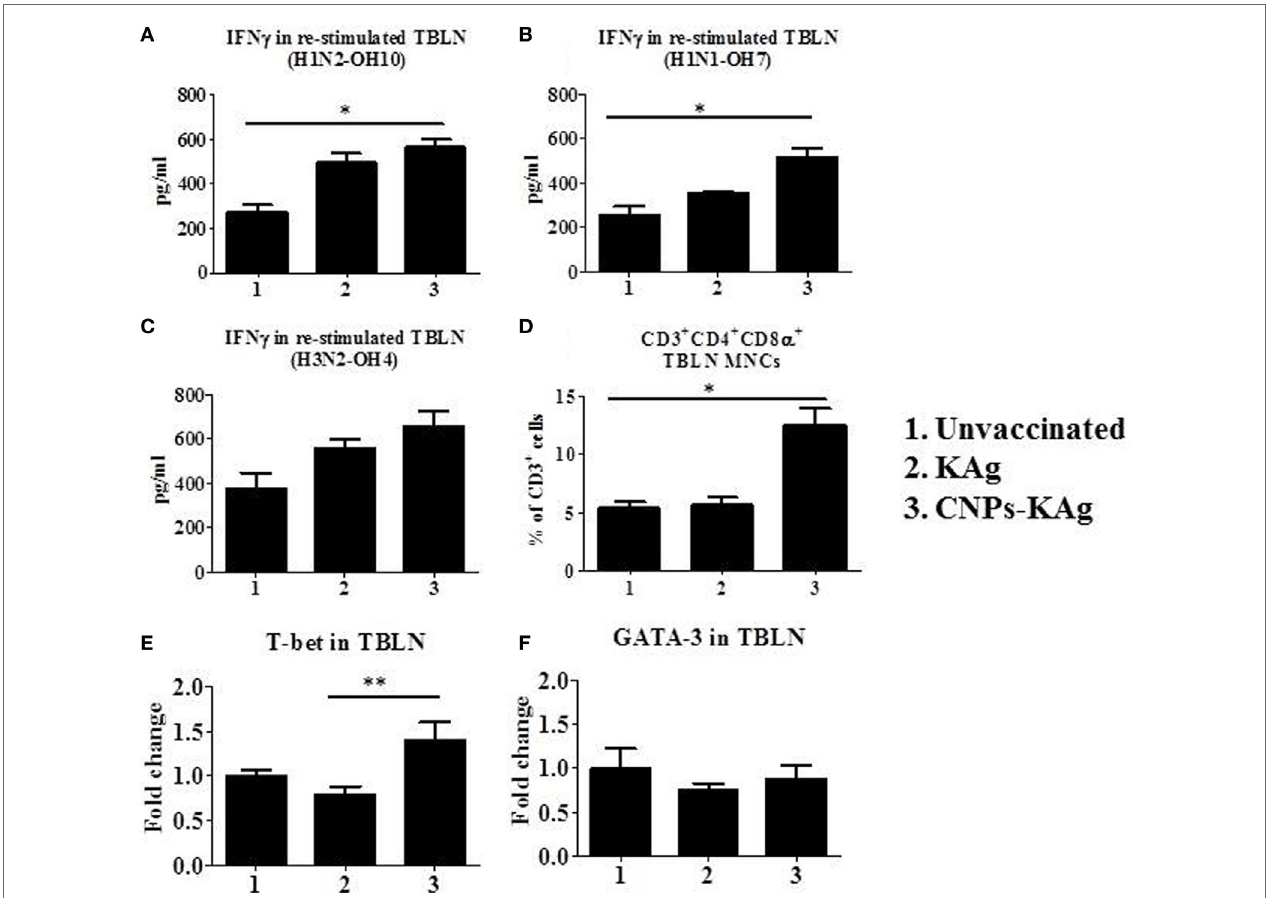
FigUre 9 | Cell-mediated immune response in TBLN-MNCs of pigs vaccinated with chitosan nanoparticles (CNPs)-KAg at day post-challenge (DPC) 6. TBLN- MNCs isolated on the day of necropsy were stimulated with different variant swine influenza A viruses (SwIAVs), and secreted IFN γ into the culture supernatant was measured by cytokine ELISA against (a) H1N2-OH10, (B) H1N1-OH7, and (c) H3N2-OH4 influenza A virus (IAVs). (D) The frequency of T helper (Th)/memory cells (CD3 + CD4 − CD8 α + ) in TBLN-MNCs of CNPs-KAg-vaccinated pigs was analyzed by flow cytometry. The expression of Th1 (e) and Th2 (F) transcription factors were also determined in TBLN at DPC 6. Data represent the mean value of three to five pigs ± SEM. Statistical analysis was carried out using Kruskal–Wallis test followed by Dunn’s post hoc test. Asterisk refers to the statistical significant difference between the indicated two pig groups (* p <